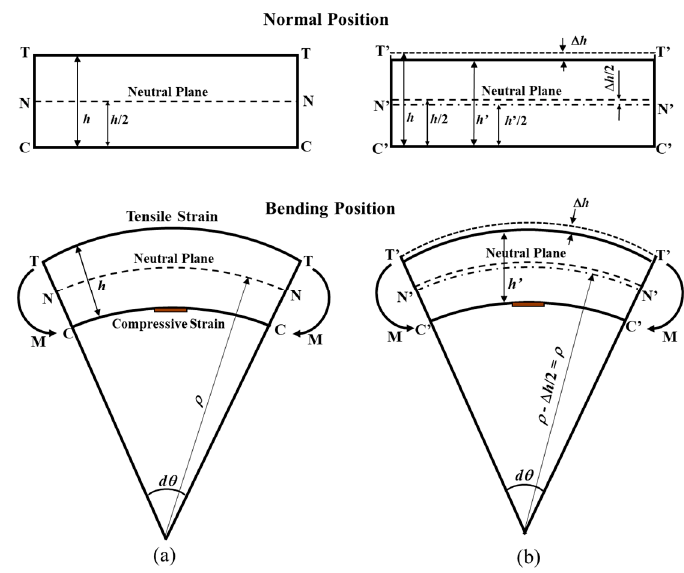
Figure 1. The illustration of test piece in normal position and bending position: ( a ) non-corroded test piece, ( b ) corroded test piece. T(T’), N(N’), and O(O’) denote the tensile, neutral, and compressive planes. M(M’) denotes the bending moment.